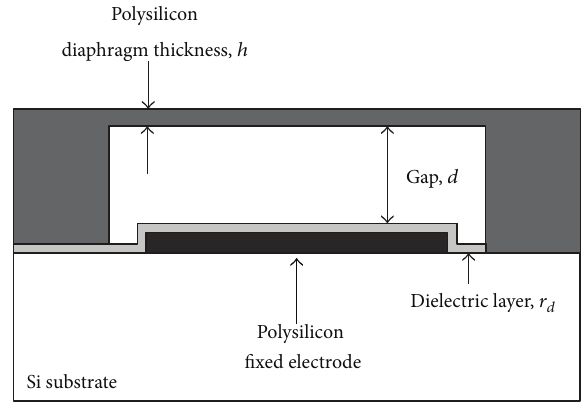
Figure 2: Structure of MEMS touch mode capacitive pressure